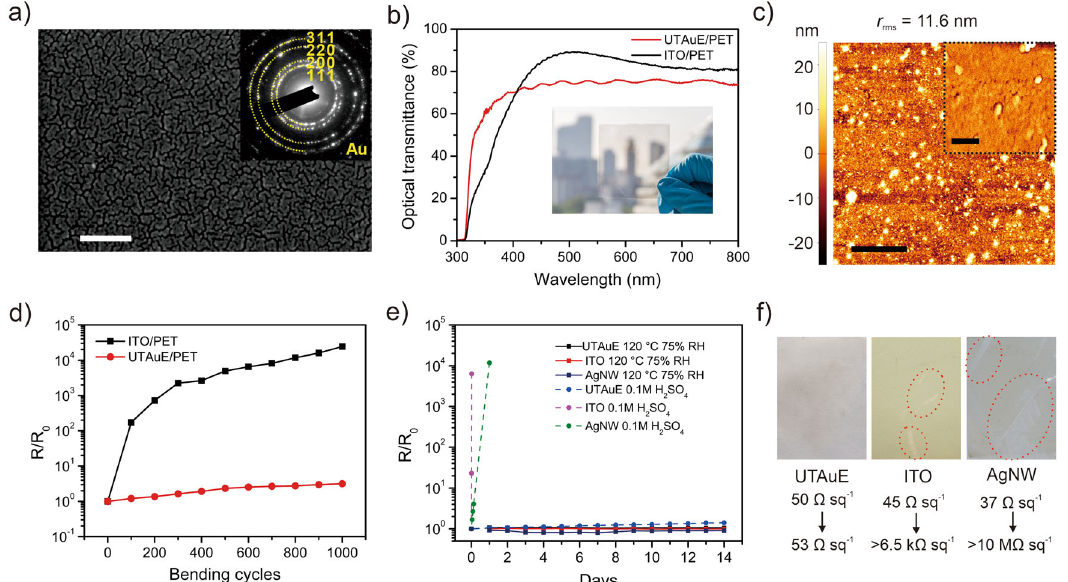
Fig. 3 Optical, electrical, and mechanical properties of the UTAuE. a SEM top view image of the UTAuE. Scale bar is 200 nm. Inset is the TEM diffraction pattern of the UTAuE. b UV – Vis transmittance spectra of UTAuE/PET fabricated with 2.5 mM HAuCl 4 in comparison to commercial ITO/PET. Inset is a photograph of 5 × 5 cm UTAuE/PET. c AFM topographic image of the UTAuE fabricated with 2.5 mM HAuCl 4 on PET substrate. Scale bar is 5 µm. Inset is the 1 × 1 µm topographic image of the UTAuE (scale bar is 250 nm). d The R/R 0 value of UTAuE/PET and ITO/PET during 1000 cycles of repeated bending at a radius of 1.5 mm. R 0 refers to the initial resistance of each electrode. e The R/R 0 of UTAuE/PET, ITO/ PET, and AgNW/PET during the 14 days aging test under 120 °C/ 75% RH, or in 0.1 M H 2 SO 4 . f Photographs of UTAuE/PET, ITO/PET, and AgNW/ PET after the Scotch Tape Test. Scotch ® Flatback Masking Tape 250 (peel adhesion 8.5 N cm − 1 ) is used for this